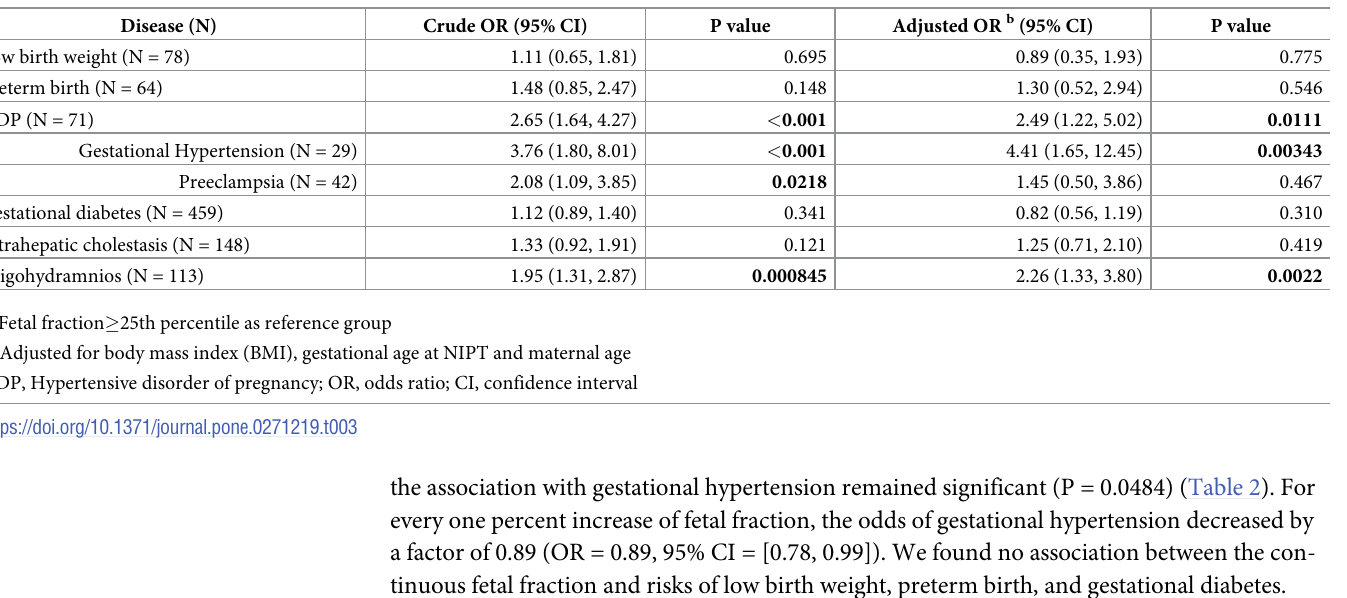
the association with gestational hypertension remained significant (P = 0.0484) (Table 2). For every one percent increase of fetal fraction, the odds of gestational hypertension decreased by a factor of 0.89 (OR = 0.89, 95% CI = [0.78, 0.99]). We found no association between the con- tinuous fetal fraction and risks of low birth weight, preterm birth, and gestational diabetes. The fetal fraction distributions comparing women with gestational hypertension versus nor- mal women, women with oligohydramnios versus normal women (S1 and S2 Figs) reveal that the maximum segregation of distribution occurs around the 25 th percentile (fetal fraction = 15.15%).